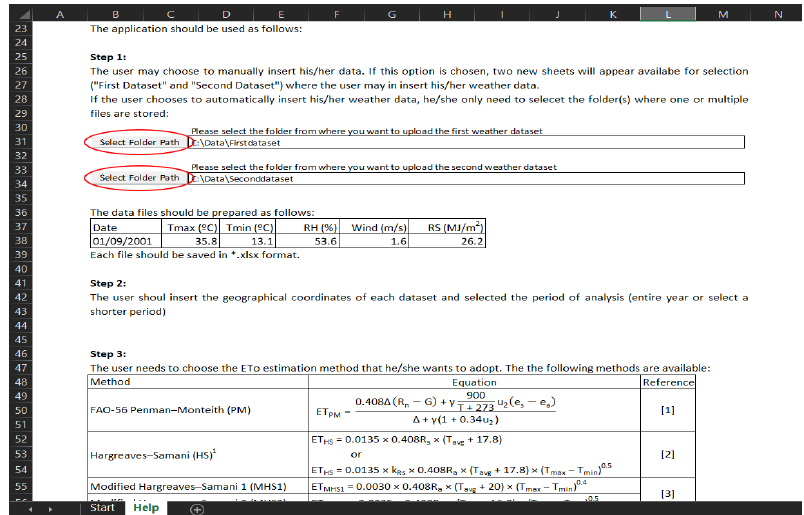
Figure 3. ETo Tool interface: help.